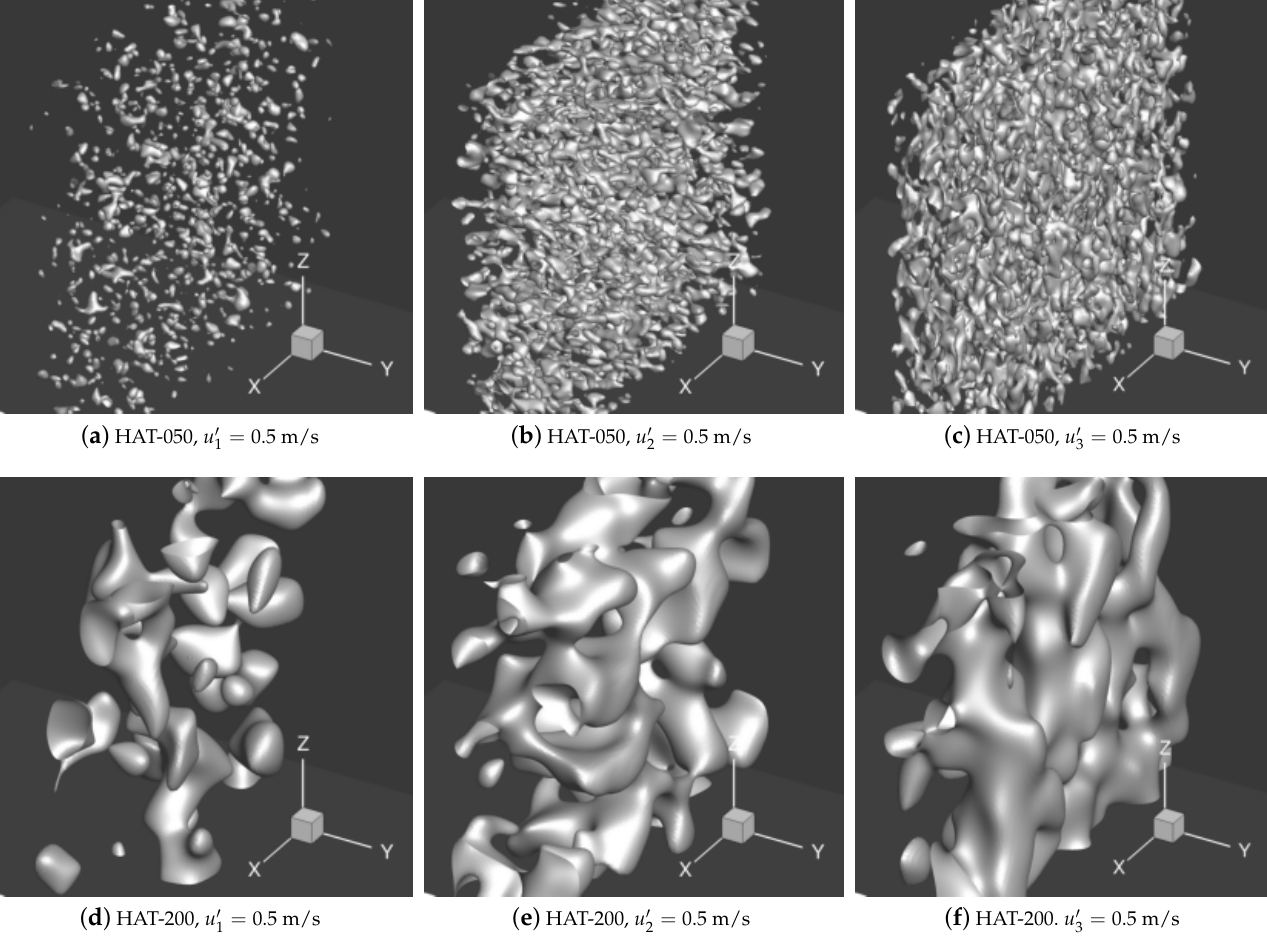
Figure 3. Iso-surfaces of the initial velocity fluctuations in the cases homogeneous anisotropic turbulence (HAT-050 and